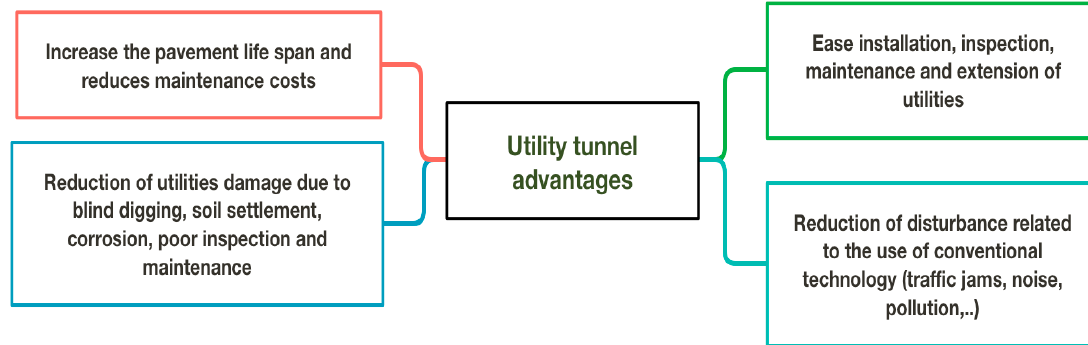
Figure 1. Main advantages of utility tunnels.